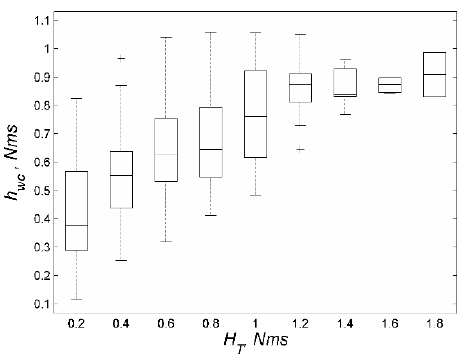
Figure 13. Box diagram of target’s angular momentum vector and angular momentum of reaction wheels.